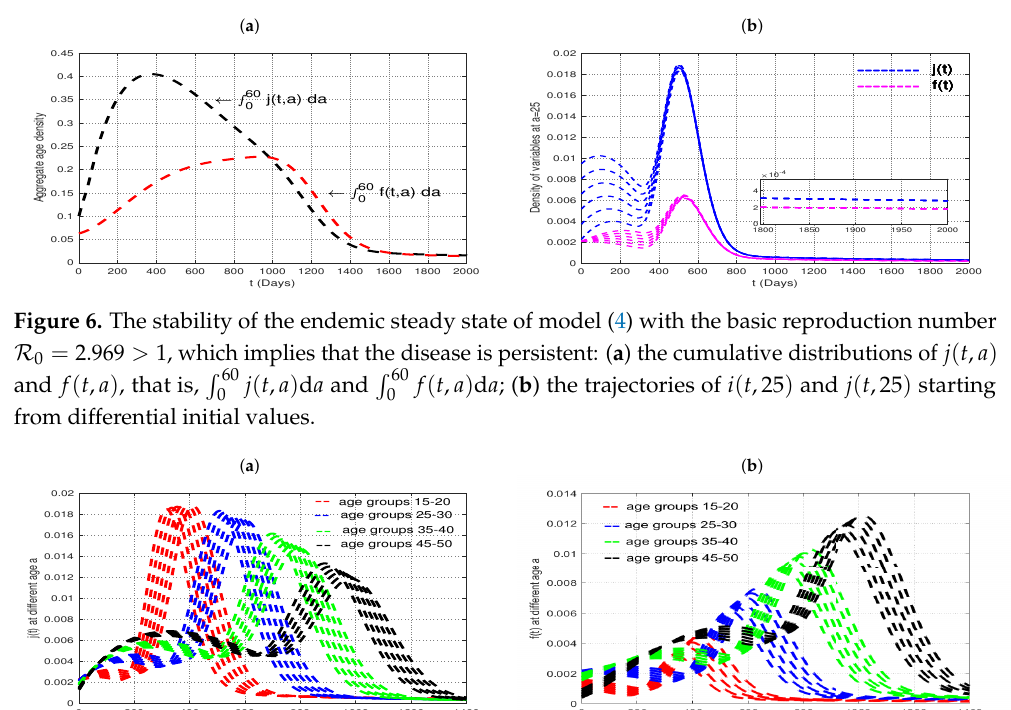
Figure 5. The distribution of solution for model (4) with the basic reproduction number R 0 = 2.969 > 1: ( a ) the distribution of s 1 ( t , a ) ; ( b ) the distribution of s 2 ( t , a ) ; ( c ) the distribution of j ( t , a ) ; ( d ) the distribution of f ( t , a ) .